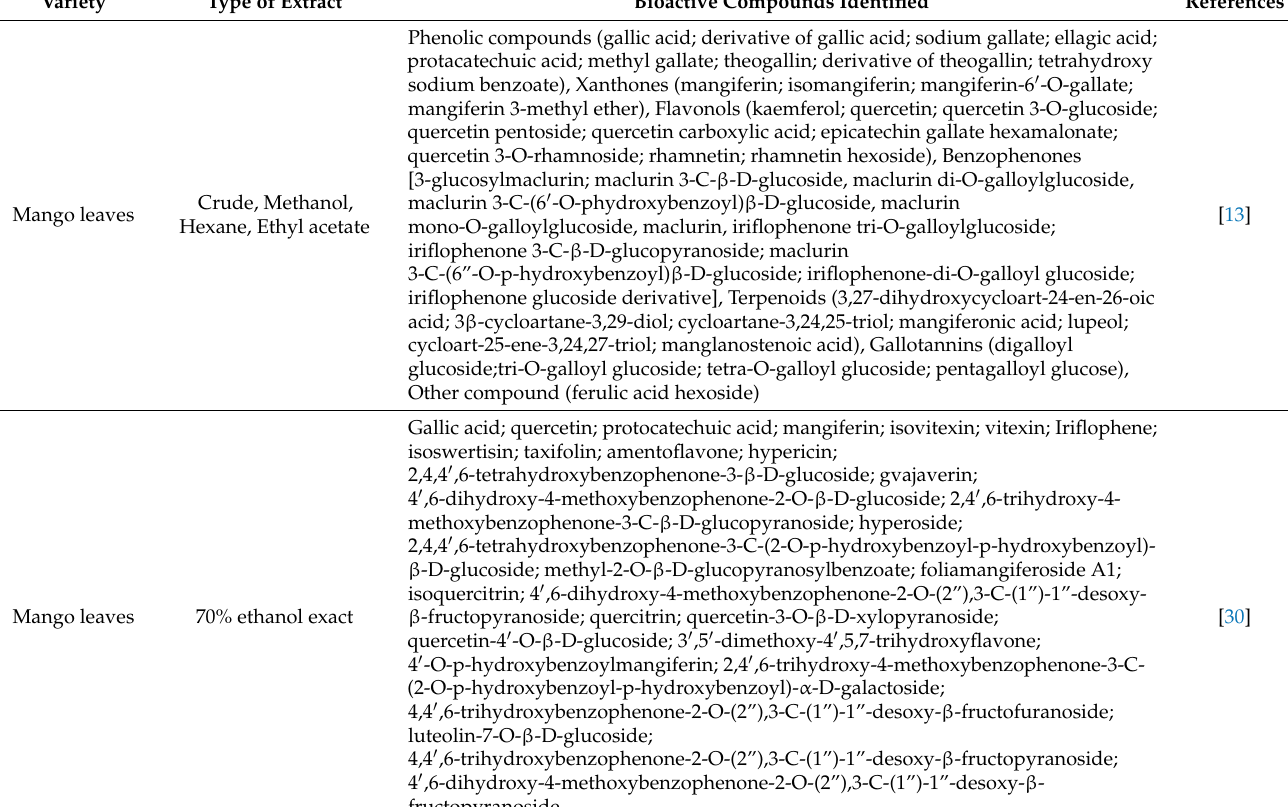
Table 3. Phytochemical profile of the mango